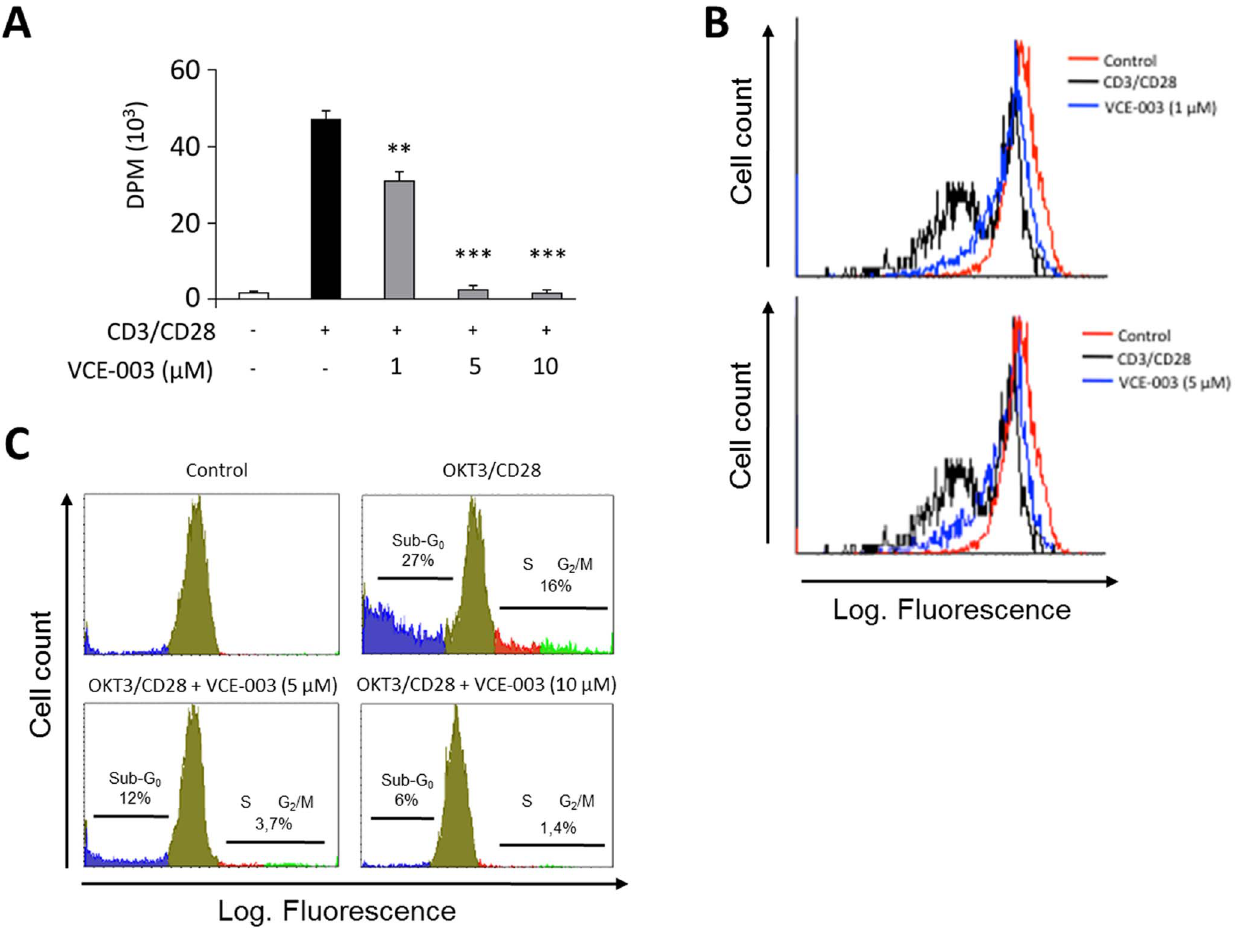
Figure 1. Effects of VCE-003 on T-cell proliferation. (A) Human peripheral T cells were stimulated with the OKT3 (1 m g/ml) and anti-CD28 (0.5 m g/ml) mAbs for 72 h in the presence or absence of increasing concentrations of VCE-003. Thymidine [ 3 H] incorporation was measured by liquid scintillation and represented as the mean d.p.m 6 SEM. Three independent experiments were performed. **p # 0.01 and ***p # 0.005 in an unpaired two-tailed Student’s t test. (B) T cells were stained with CFSE, pre-treated with VCE-003 and stimulated with the CD3/CD28 mAbs for 6 days. Cell division was identified by flow cytometry. (C) T-cells were pre-treated with VCE-003 and stimulated with the CD3/CD28 mAbs for 72 h. The percentage of subdiploid cells (sub-G 0 ), and cells entering the S and G 2 /M phases of the cell cycle are indicated. The results are representative of three independent experiments.